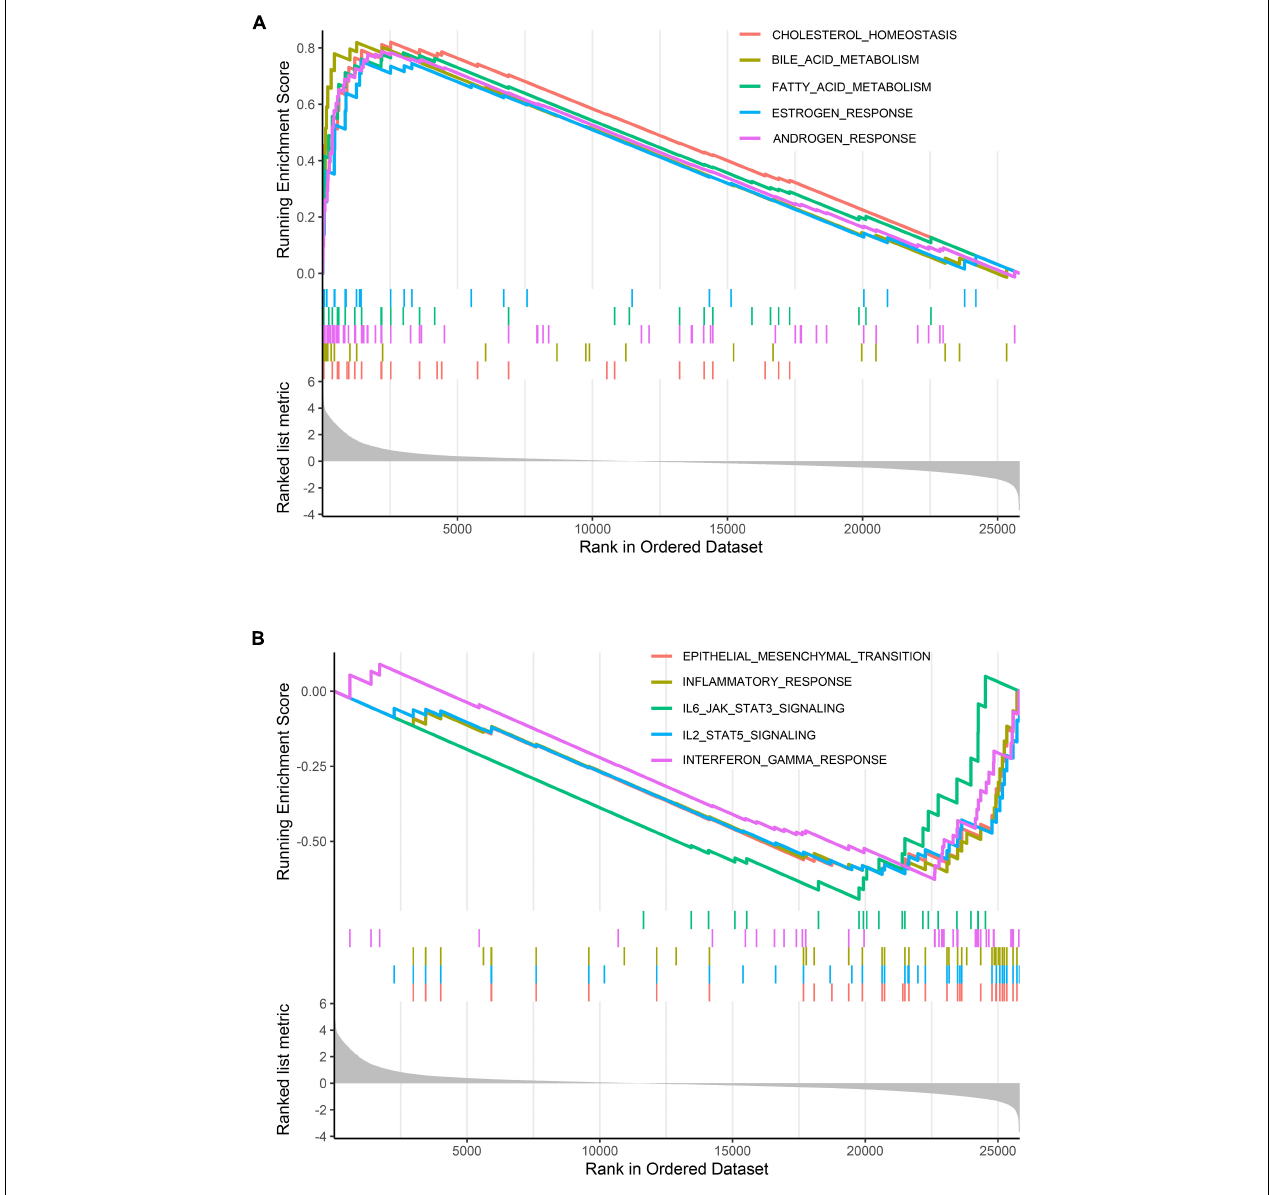
FIGURE 2 | Gene set enrichment analysis (GSEA). (A) Top five gene sets enriched in cystic CC group. (B) Top five gene sets enriched in fusiform CC